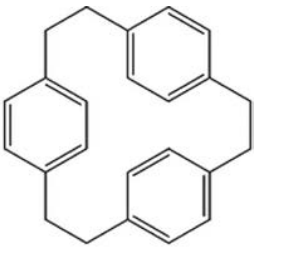
Figure 1 . Structural formula of [2.2.2]paracyclophane (C 24 H 24 ).